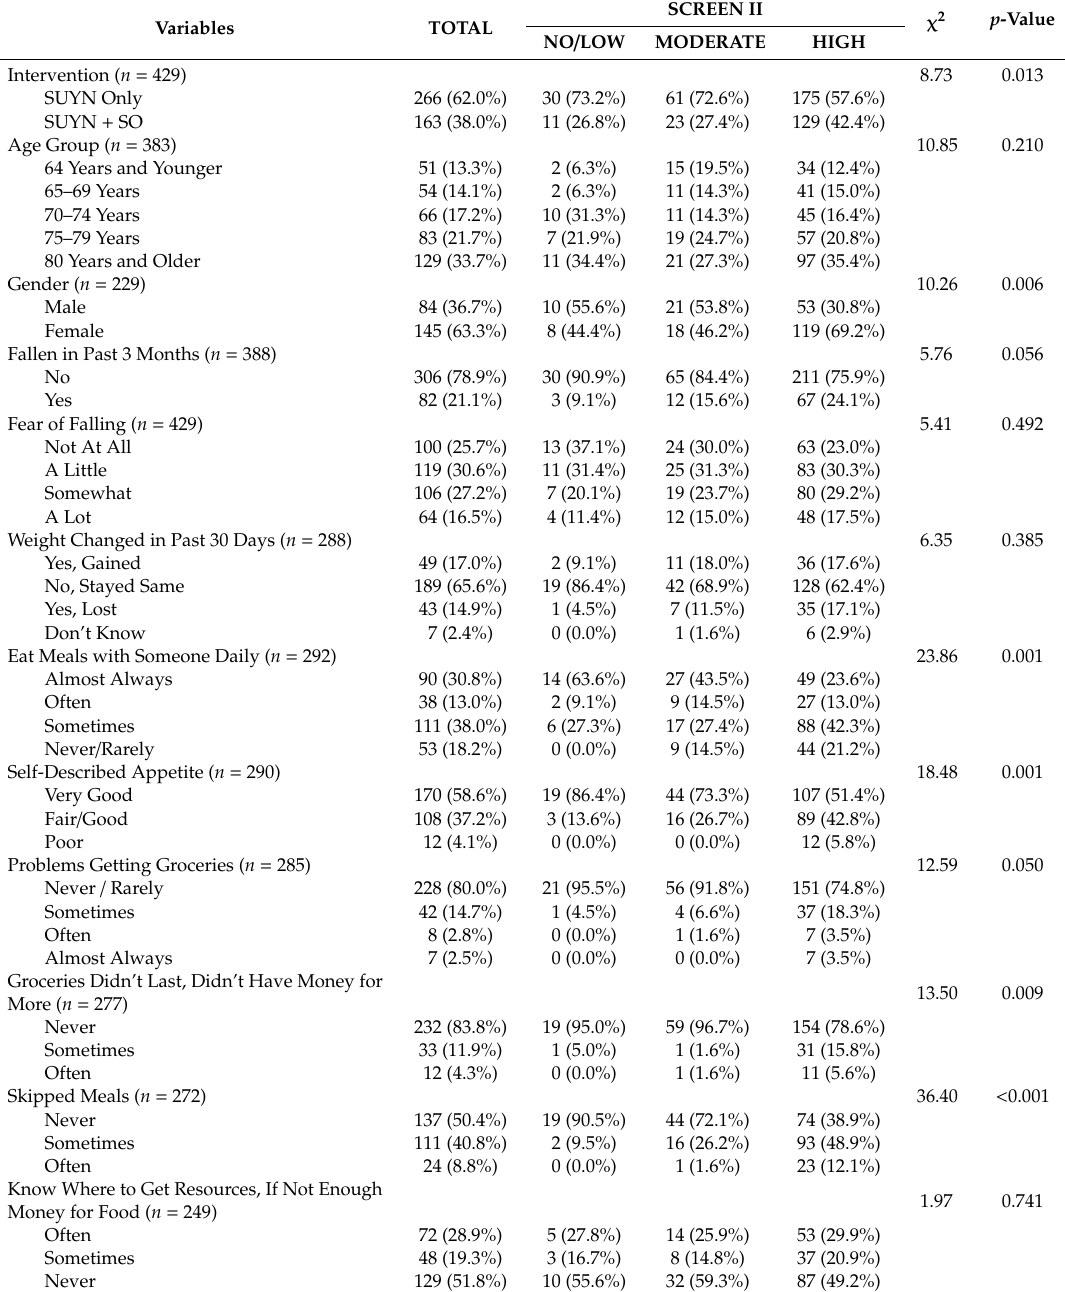
Table 2. Baseline Characteristics for SUYN Participants by Malnutrition Risk